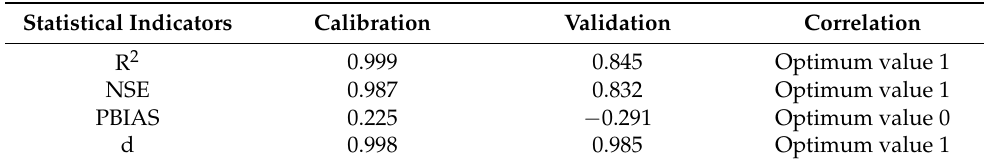
Table 1. Statistical indicators for the calibration and validation processes for the Biob í o River study section.